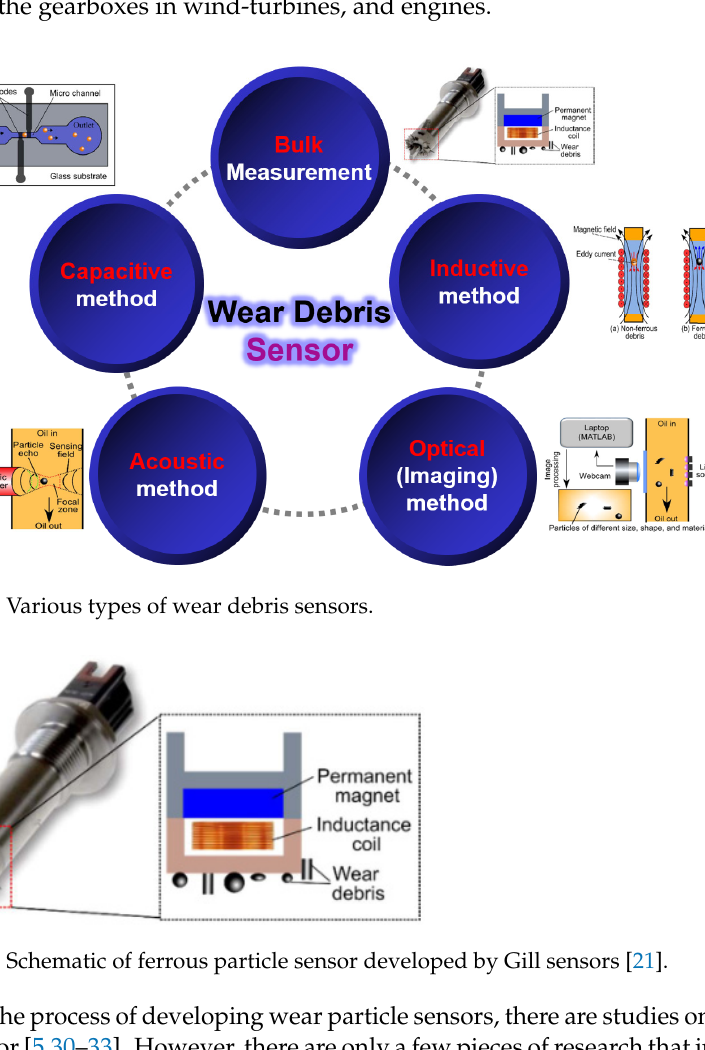
Figure 2. Various types of wear debris sensors.